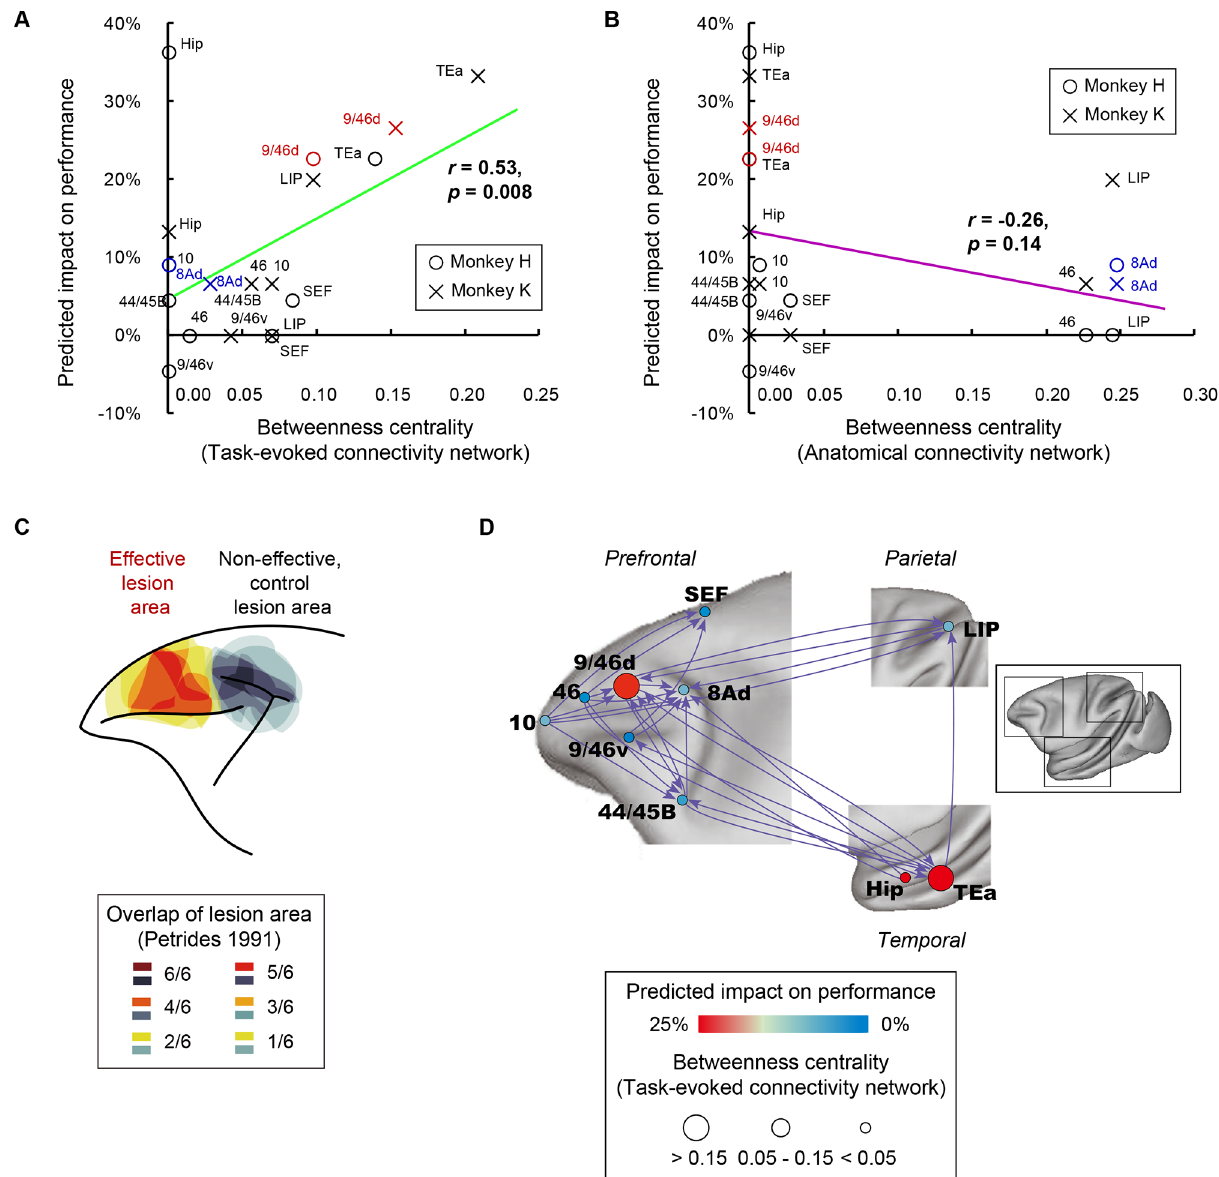
Fig 6. Relationship of betweenness centrality and predicted behavioral impairment after lesioning. (A) Betweenness centrality calculated based on task-evoked connectivity (horizontal axis) and predicted impact on performance (vertical axis) for each area for each monkey are plotted as a scattergram. The green line was fitted ( r = 0.53, p = 0.008). (B) Betweenness centrality calculated based on anatomical connectivity (horizontal axis) and predicted impact on performance (vertical axis) for each area for each monkey are plotted as a scattergram. The purple line was fitted ( r = -0.26, p = 0.14). (C) Areas where lesions induced impairment in temporal-order judgment; data were compiled from Petrides (1991) [18]. Red-yellow color code and gray code indicate the overlap of the lesion area among six hemispheres for mid-dorsolateral prefrontal area (effective lesion area) and periarcuate area (noneffective, control lesion area), respectively. (D) Schematic illustration of interareal connections. PPIs with p < 0.01 (FDR correction) are displayed as directed edges for display purpose. Node color indicates predicted impact on performance. Node diameter represents betweenness centrality. Note that causality cannot be inferred from PPI